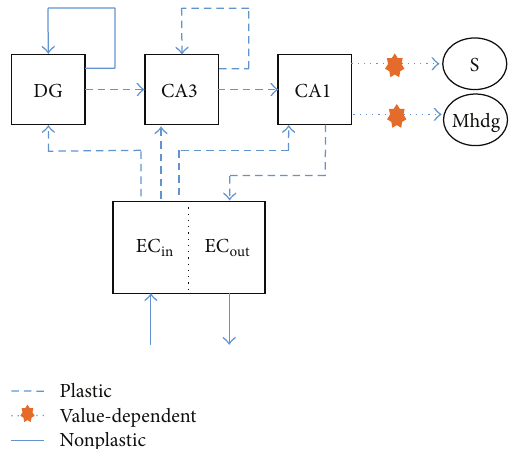
Figure 3: Neural connectivity of the medial temporal lobe, includ- ing the hippocampus of Darwin XI. Hippocampus: DG, dentate gyrus, and CA3 and CA1 (CA, cornus ammonis). Entorhinal cortex (EC): EC in and EC out . Neural interfaces to external sensors: S, value system and Mhdg, motor.